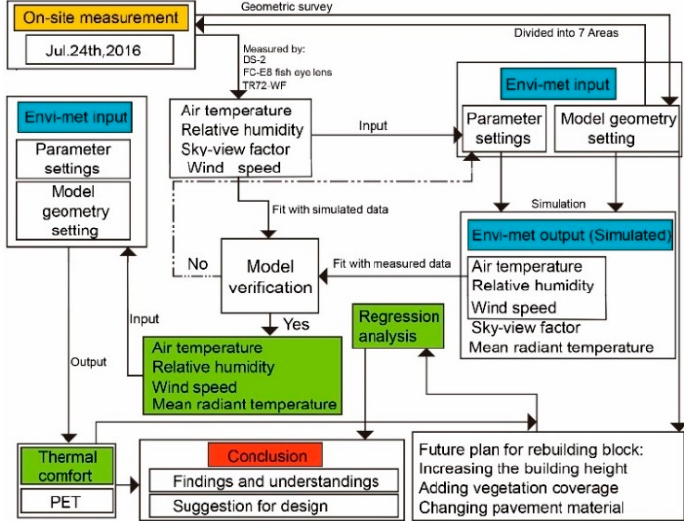
Figure 8. Methodological framework of this study. (PET: physiological equivalent temperature).